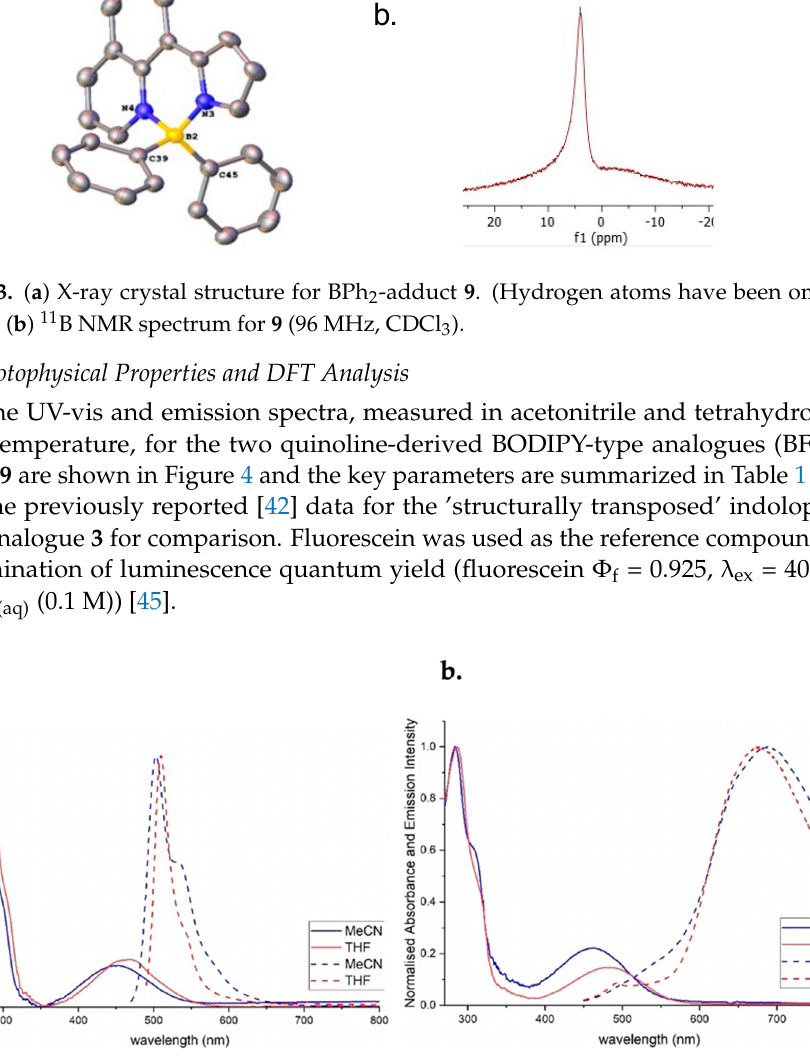
Figure 4. Normalized absorption (solid lines) and emission spectra (dashed lines) of ( a ) pyrrol- ylquinoline-BF 2 8 and ( b ) -BPh 2 9 in MeCN and THF. ( a ) pyrrolylquinoline-BF 2 8 and ( b ) -BPh 2 9 in MeCN and